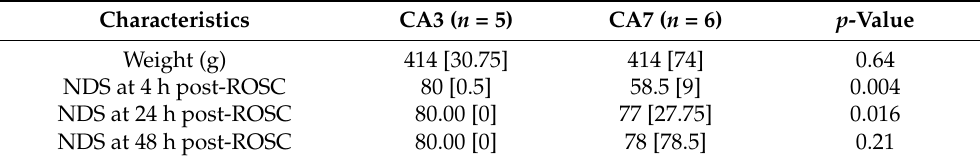
Table 1. Animal characteristics grouped by the duration of cardiac arrest (CA) (median [interquartile range]). NDS, neurologic deficit scale. ROSC, return of spontaneous circulation. CA3, 3-min CA. CA7, 7-min